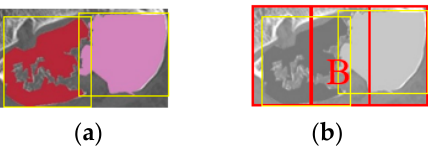
Figure 15. Steps to determine the type of fracture in case of fragment fracture: ( a ) The region of the